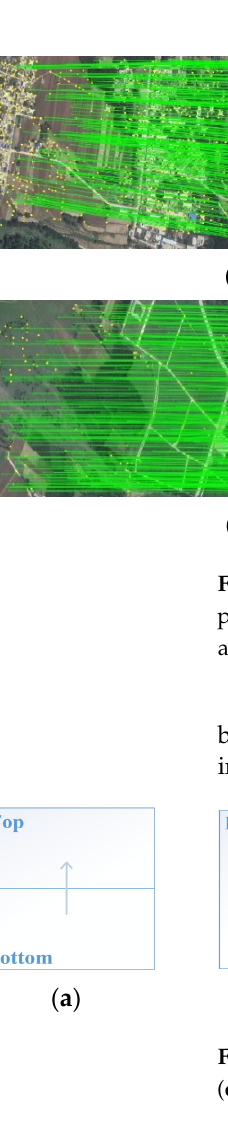
Figure 11. Division of an image in five directions: ( a ) horizontal, ( b ) vertical, ( c ) 45°, ( d ) 135°, and ( e ) center and periphery.